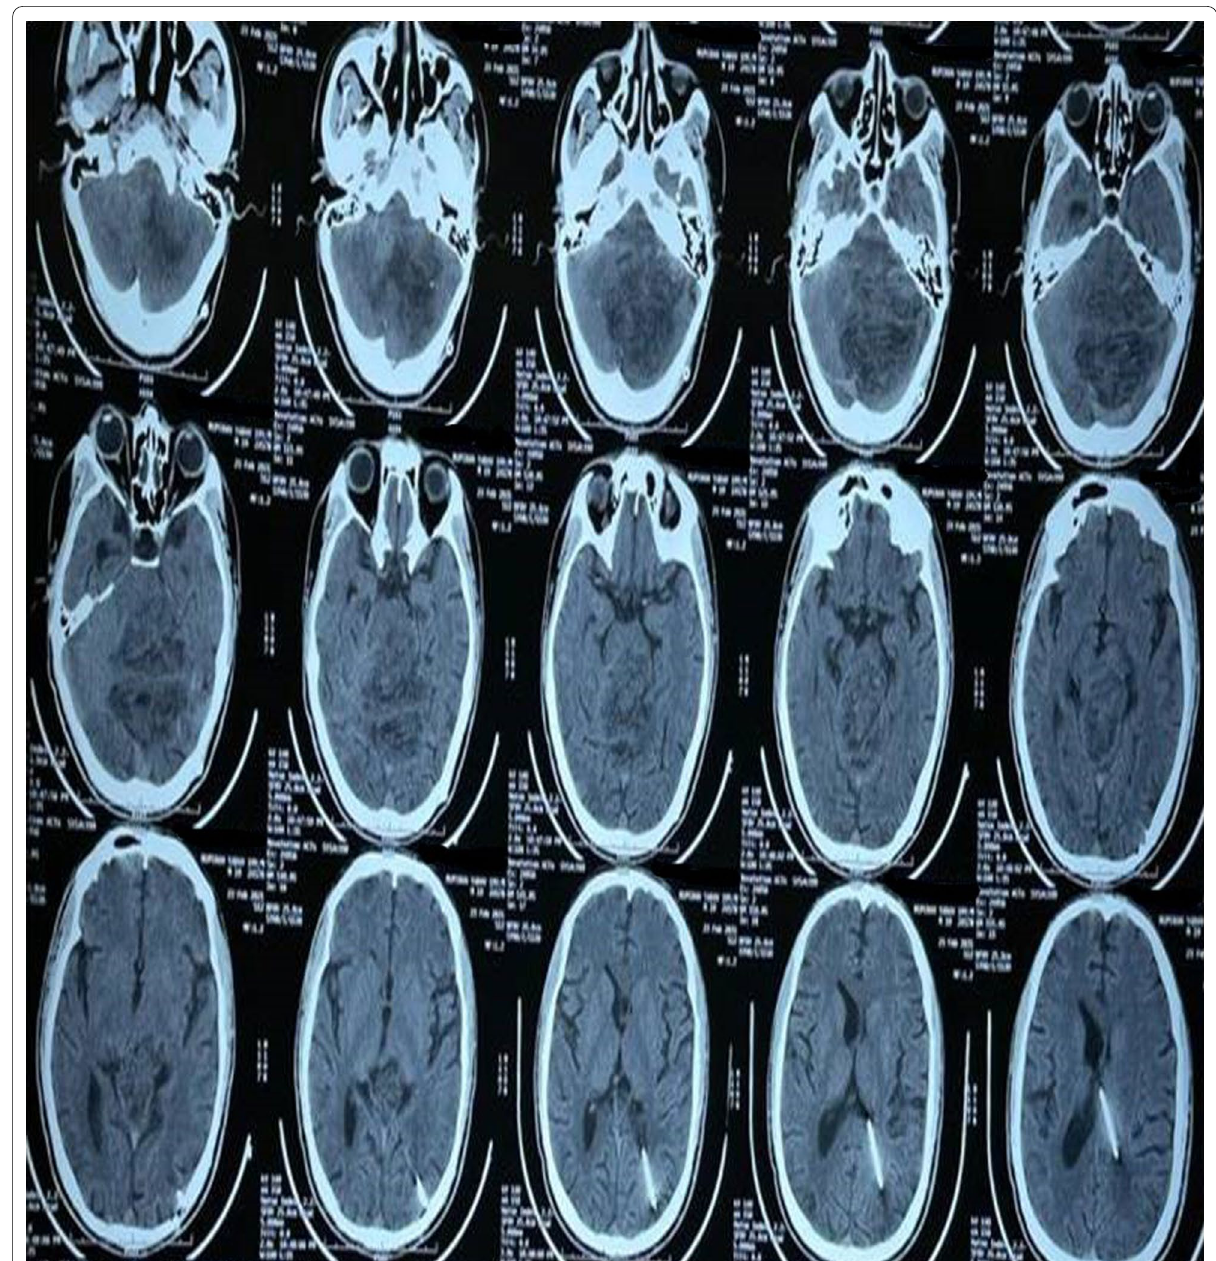
Fig. 1 Preoperative CT scan showing hypo-dense lesion involving left cerebellar hemisphere and vermis with bands of hyper-densities inside the lesion, compressing brainstem and non-visualization of fourth ventricle cavity, and presence of shunt inside the left lateral ventricle